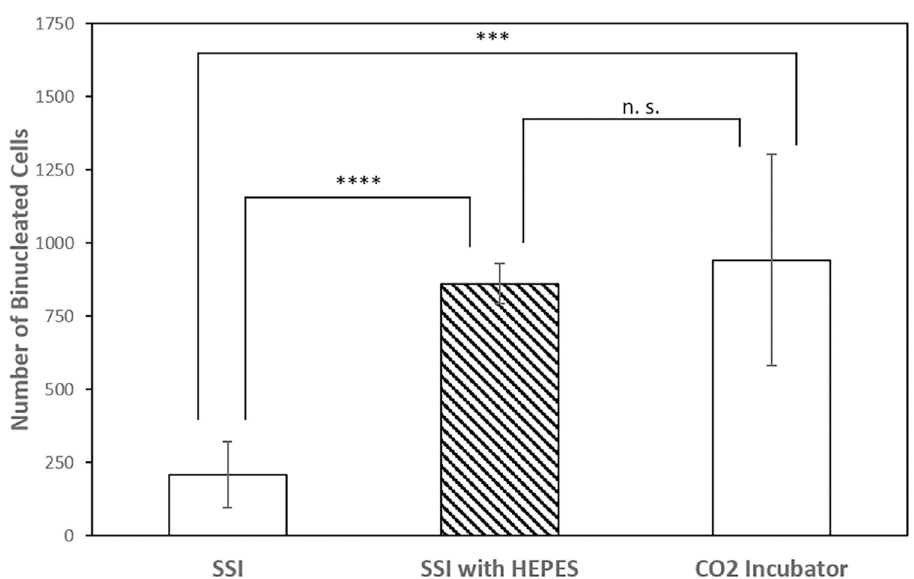
Fig 6. The number of BN cells under three culture conditions: In SSI with and without HEPES buffer, and in a traditional CO 2 incubator. ��� represents a p-value less than 0.001 and ���� represents a p-value less than 0.0001. “n. s.” stands for “not significant” (p-value larger than 0.0167). https://doi.org/10.1371/journal.pone.0268508.g006 incubator with cyt-B added manually at 24-hour time point. All the samples were harvested after 54 hours of culture and then analyzed for CBMN assay. Three shipments were conducted with each shipment containing blood samples from one donor (total three donors). The aver- age of the three shipments was used to plot the dose curve. Fig 7A shows the dose curves for SSI and the conventional process. Clear dose-dependent MN/BN ratios have been observed both by SSI and the conventional control. Fig 7B shows that there is a strong correlation between the MN/BN ratios obtained using the SSI and a control process with a Pearson’s cor- relation coefficient of P = 0.9972 and 95% confidence interval of (0.9540, 0.9998). This suggests